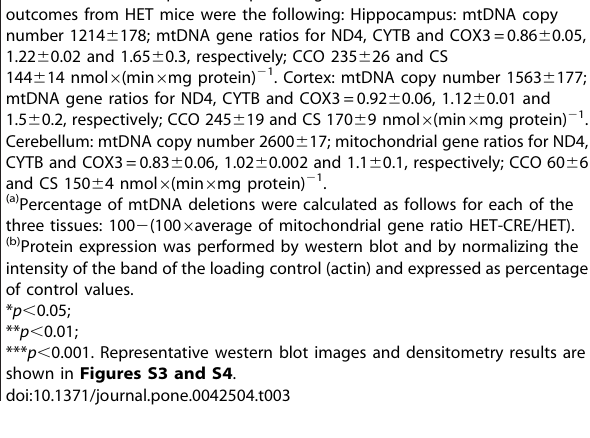
All outcomes were expressed as percentages of HET values. The values for the outcomes from HET mice were the following: Hippocampus: mtDNA copy number 1214 6 178; mtDNA gene ratios for ND4, CYTB and COX3=0.86 6 0.05, 1.22 6 0.02 and 1.65 6 0.3, respectively; CCO 235 6 26 and CS